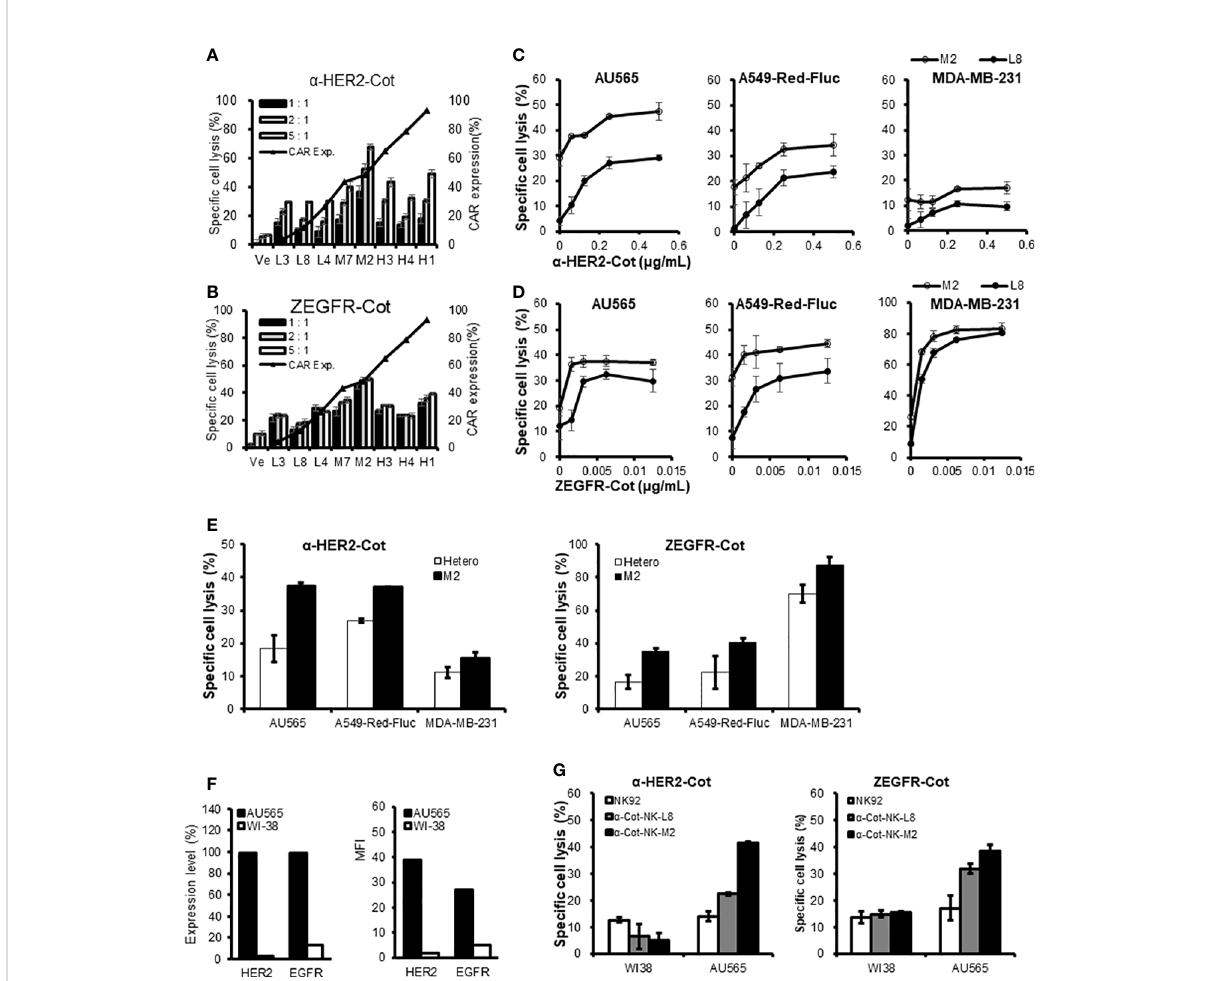
FIGURE 6 Monoclonal a -Cot-NK92 cell lines have different killing potentials. (A, B) a -Cot-NK92 clones were established through single cell sorting using FACS in an expression level-dependent manner for CAR-Myc. Black triangles with a line indicate the expression level of CAR-Myc. The ability of a -Cot-NK92 clones to lyse AU565 cells was assessed using co-culture with a -HER2-Cot (A: 500 ng/mL) or ZEGFR-Cot (B: 50 ng/mL) for 4 h at E:T ratios of 5:1, 2:1, and 1:1. Ve: vehicle. (C, D) Comparison of cytolytic potency between low (L8) and medium (M2) CAR-expressing a -Cot- NK92 clones through co-culture with AU565, A549-Red-Fluc, or MDA-MB-231 cells in a dose-dependent manner of a -HER2-Cot (C: from a concentration of 500 to 62.5 ng/mL, upper panel) or ZEGFR-Cot (D: from a concentration of 12.5 to 1.56 ng/mL, lower panel). (E) Comparison of cytolytic potency between M2 clone and heterogeneous a -Cot-NK92 cells through co-culture with AU565, A549-Red-Fluc, or MDA-MB-231 cells with a -HER2-Cot (125 ng/mL) or ZEGFR-Cot (6.25 ng/mL). (F) Relative expression level (%) and mean fl uorescence intensity (MFI) of HER2 and EGFR in breast cancer cells (AU565) and normal lung cells (WI-38). (G) Cytolytic activity of NK92, monoclonal a -Cot-NK92-L8, and a -Cot- NK92-M2 cells with ZEGFR-Cot or HER2-Cot against AU565 and WI-38 cells. CAR, chimeric antigen receptor; Cot, cotinine; NK, natural